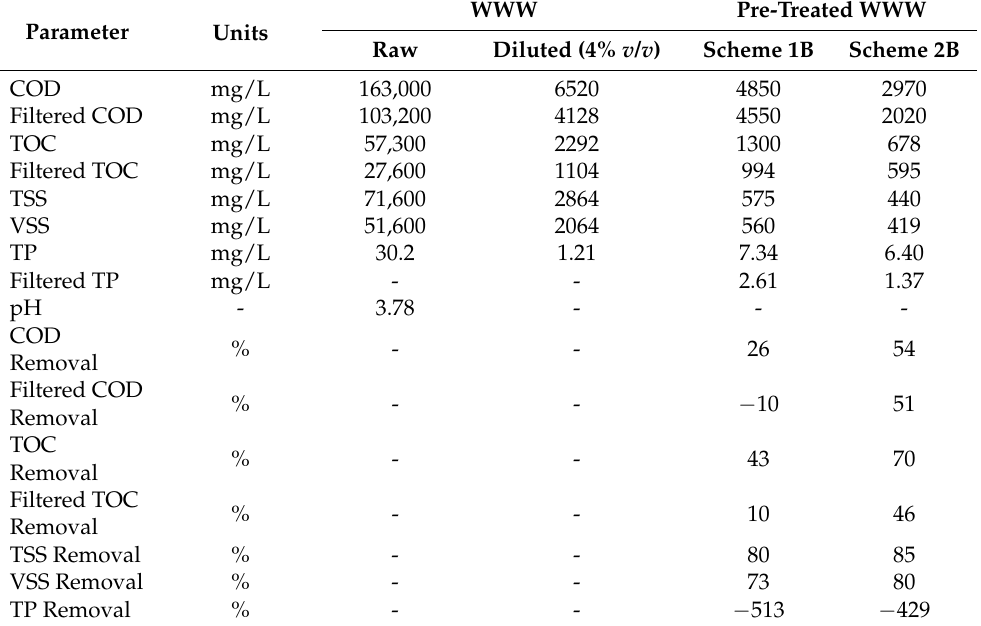
Table 2. Characteristics of actual WWW before and after pre-treatment via dilution and settling, and aerobic biological